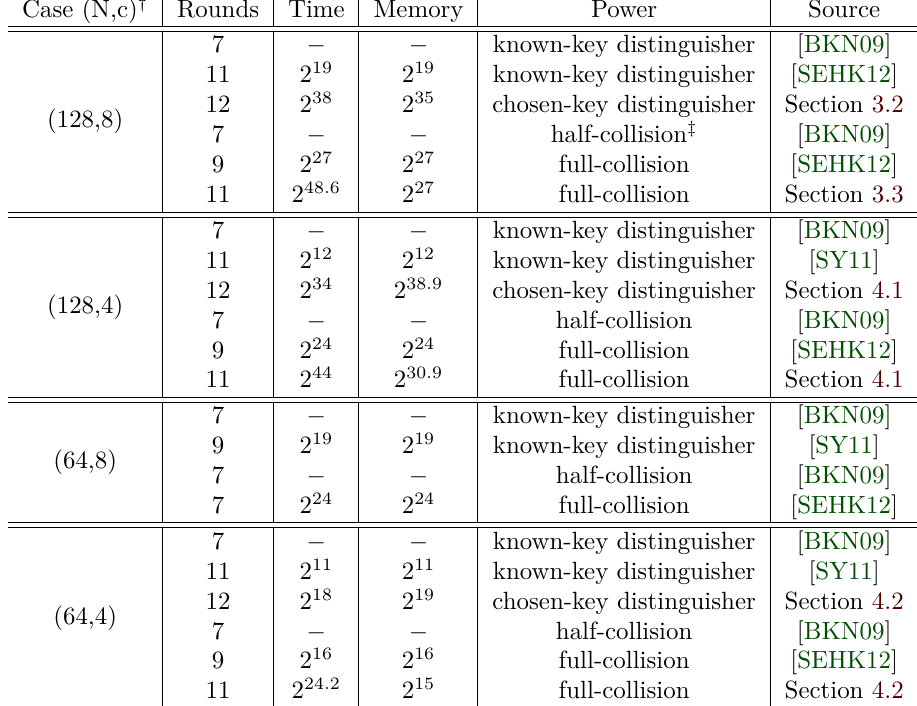
Table 1: Summary of Results for Generic Feistel-SP in Open-Key Mode Case (N,c)